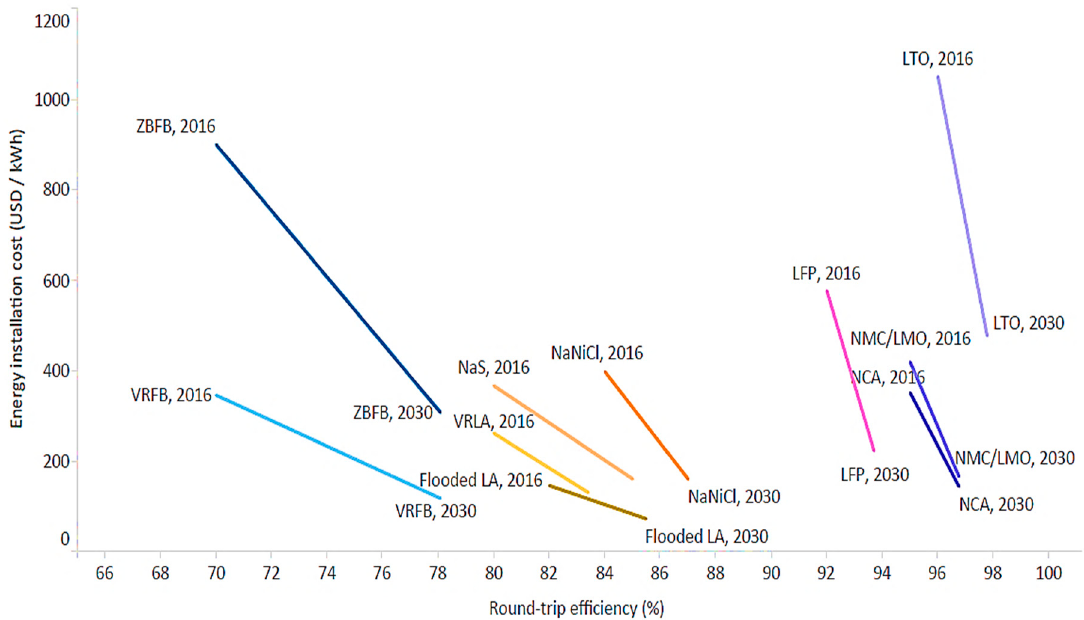
Figure 2. Energy round-trip efficiencies and installation costs of electrochemical technologies, 2016–2030 [27]. Abbreviations: LA = lead-acid; VRLA = valve-regulated lead-acid; NaS = sodium sulphur; NaNiCl = sodium nickel chloride; VRFB = vanadium redox flow battery; ZBFB = zinc bromine flow battery; NCA = nickel cobalt aluminium; NMC/LMO = nickel manganese cobalt oxide/lithium manganese oxide; LFP = lithium iron phosphate; LTO = lithium titanate.